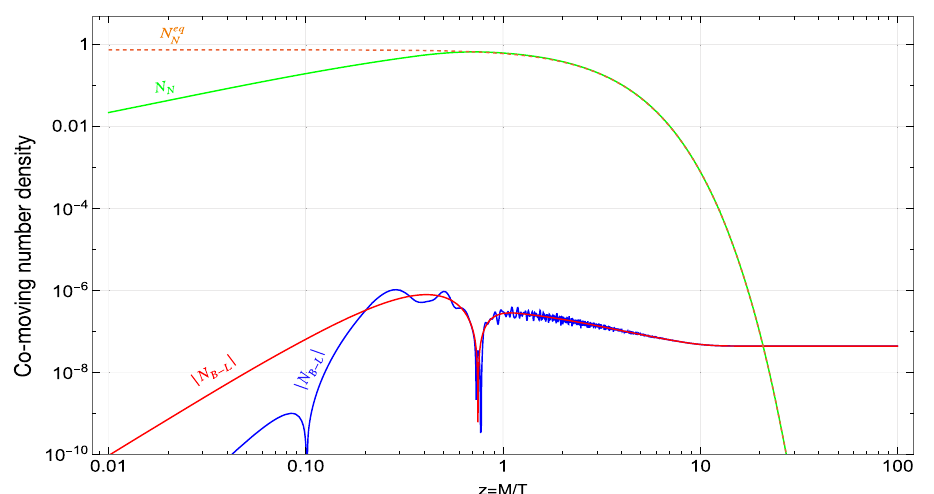
Fig. 3 B − L asymmetry and neutrino abundance evolution during the expansion of the Universe in case of zero initial neutrino abundance. The blue line refers to the full solution of the Boltzmann’s equations, obtained retaining the time dependence of the CP-violation parameter. The red line refers to the solution of the analogous system but adopting